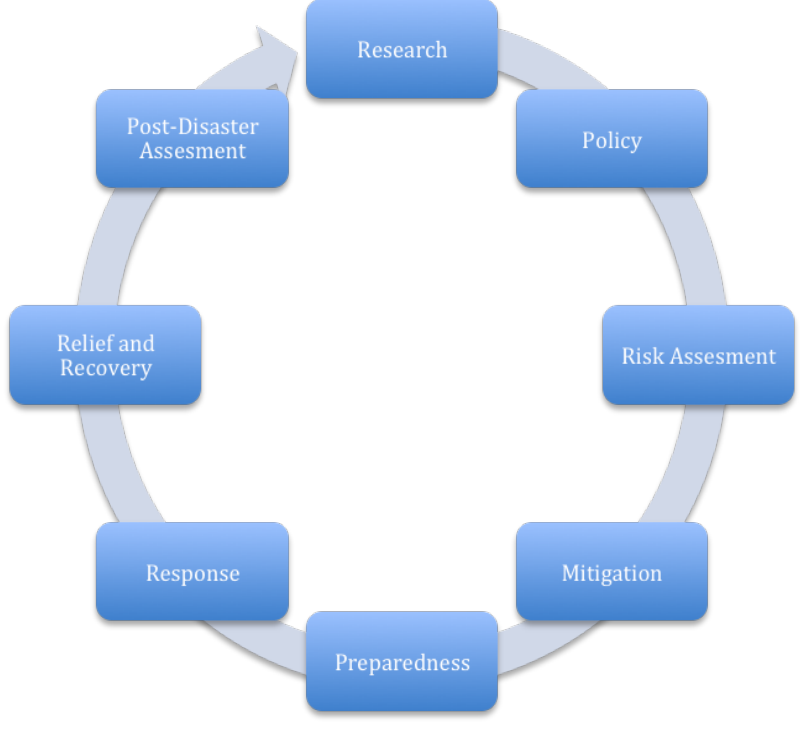
Figure 3 QLD Disaster Resilience